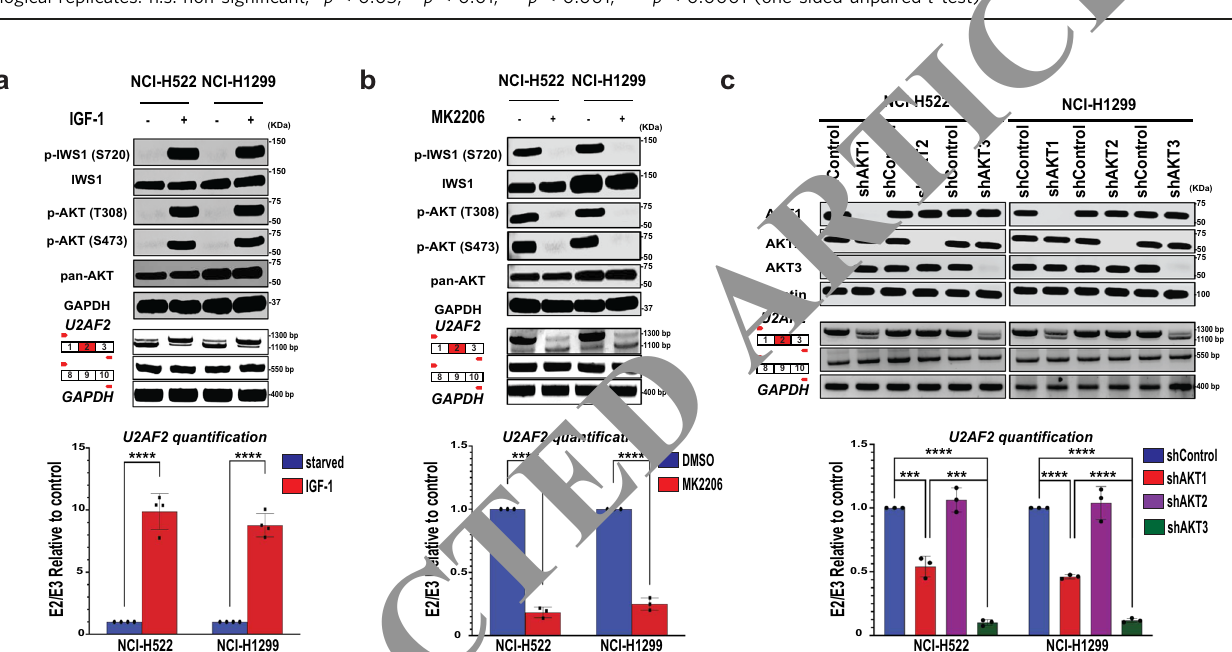
Fig. 1 IWS1 expression and/or phosphorylation regulate alternative mRNA splicing. a Western blots of NCI-H522 and NCI-H1299 cell lysates, transduced and probed with the indicated constructs and antibodies. b Overlaps between differentially-expressed and differentially spliced genes in the indicated groups ( q < 0.05). c Bar graphs of alternative splicing events with exon inclusion. The comparisons were limited to alternative splicing events with a percentage of the alternatively spliced exon spliced in (psi/ ψ ) >0.6 and a p value < 0.05. d GO analysis of statistically signi fi cant alternative splicing events in the indicated groups ( p < 0.05). Red boxes highlight gene sets involved in the regulation of RNA processing. e Volcano plots of all the exon inclusion and exclusion alternative splicing events, detected by DEXseq in the indicated groups. The statistically signi fi cant events ( p < 0.05) with a percentage spliced in (psi/ ψ ) level of >0.6 or <0.4 are shown in red. Statistically signi fi cant events in the GO functions RNA splicing or RNA metabolic processes are shown in green. Alternatively spliced IWS1 targets validated in this report are shown in blue. f (Upper panel) RT-PCR of U2AF2 in the indicated NCI-H522 and NCI-H1299 cells, using primers mapping in exons 1 and 3, 3 and 5, and 8 and 10 (control). GAPDH was used as the loading control. The U2AF2 E2/E3 ratio was calculated from the GAPDH-normalized levels of the RT-PCR products. The bars show the mean ratio ± SD in the indicated NCI-H522 and NCI-H1299 cells relative to shControl. g Sequencing chromatograms of the two alternatively spliced U2AF2 RNA transcripts. h (Upper) UCSC browser snapshot showing exons 1, 2, and 3 of the human U2AF2 gene. The map position of the PCR primer sets used in the ChIP experiments in this fi gure is indicated by blue marks. (Lower) ChIP assays of IWS1 on the U2AF2 and GAPDH genes in shControl, shIWS1 shIWS1/WT-R and shIWS1/MT-R NCI-H522 and NCI-H1299 cells. Bars show the mean fold enrichment (anti-IWS1 IP, vs IgG control IP) in IWS1 binding, in shIWS1 relative to shControl cells or in shIWS1/MT-R relative to shIWS1/WT-R cells ±SD. Data were normalized relative to the input (2%). All assays were done in triplicate, on three biological replicates. n.s: non-signi fi cant, * p < 0.05, ** p < 0.01, *** p < 0.001, **** p < 0.0001 (one-sided unpaired t